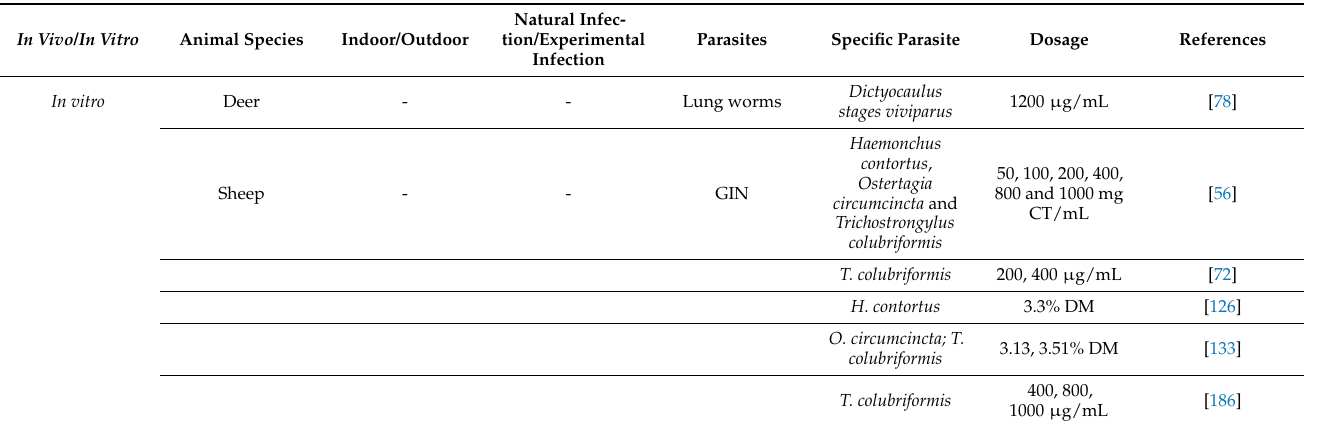
Table 5. Brief description of trials for the antiparasitic plant: Hedysarum coronarium